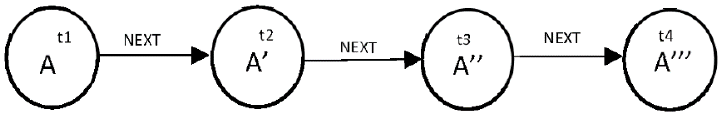
Figure 2. Flow chart of the study.